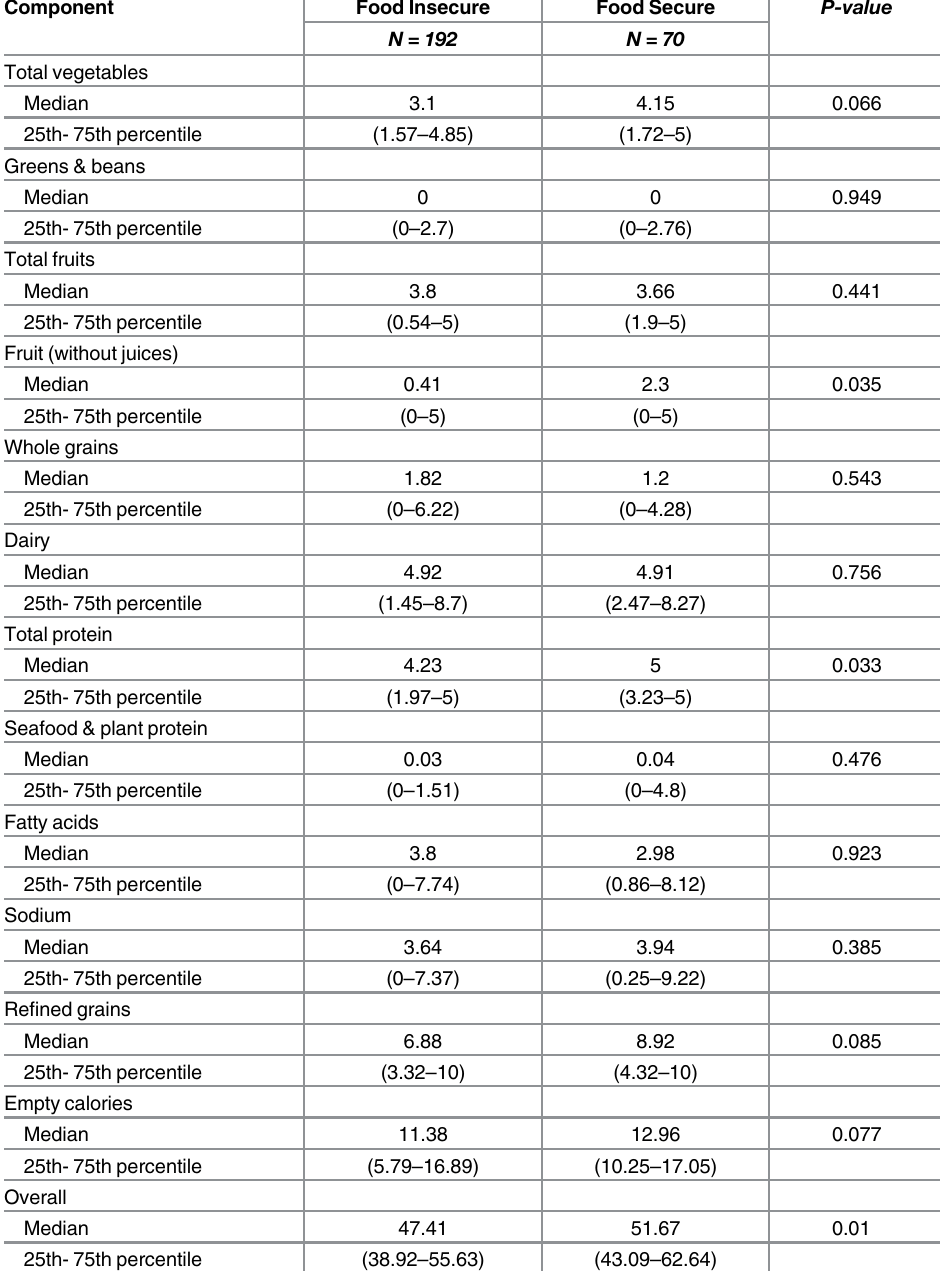
Table 4. Bivariate comparison of participant Health Eating Index (HEI) by food security